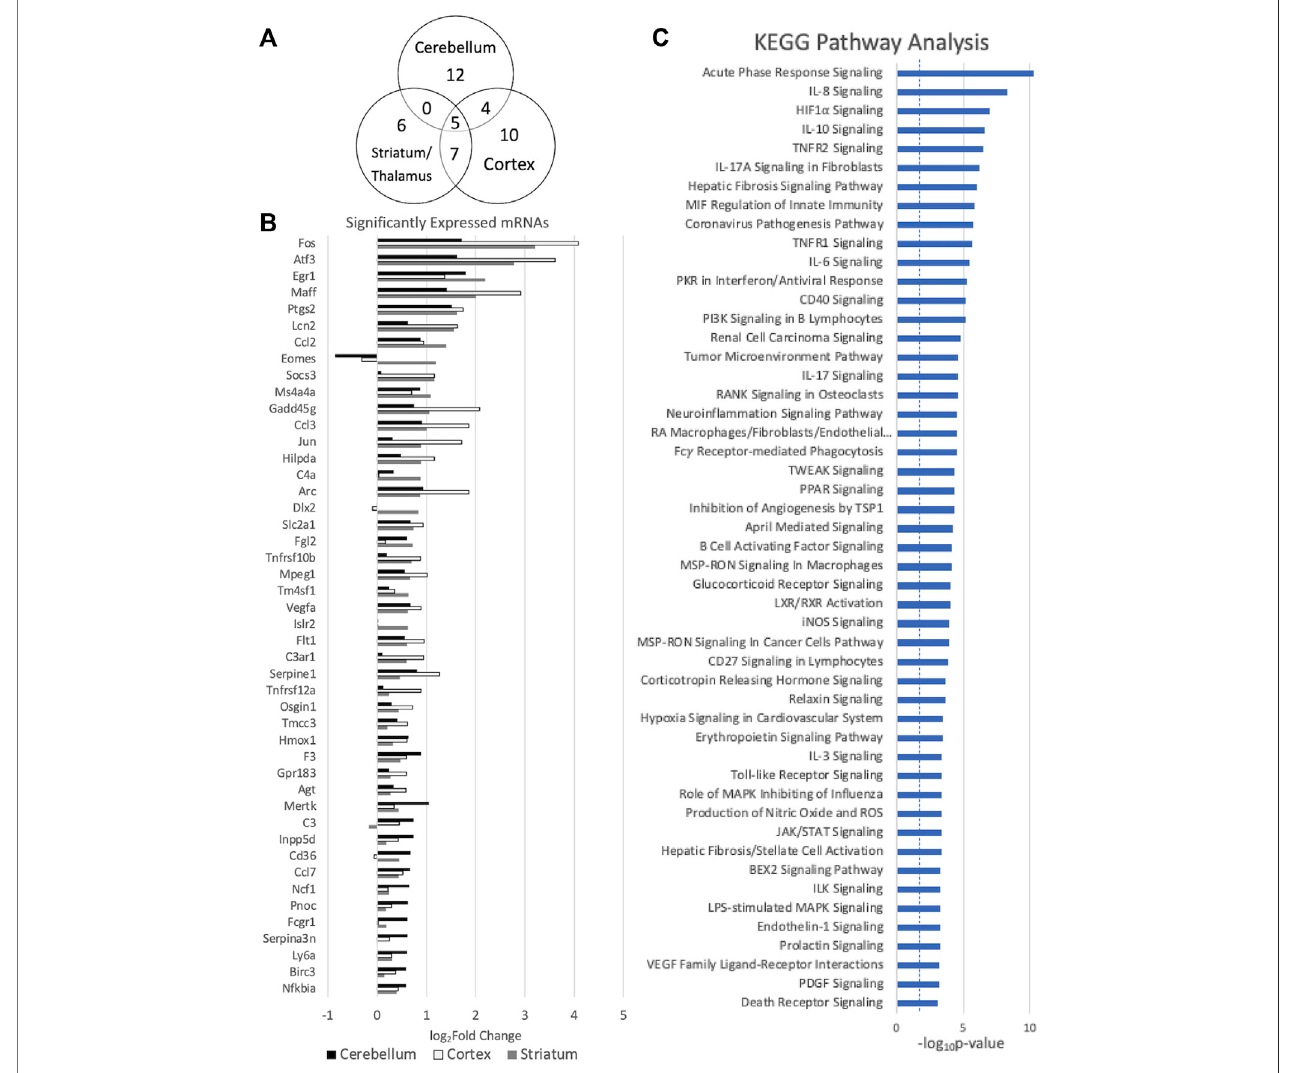
FIGURE3| MessengerRNAs(mRNA) withsigni fi cantdifferential expression inmore than one region. (A) Venn diagram demonstratingthe number ofmRNAs with signi fi cant differential expression and the overlap between each region; (B) differential expression of the mRNAs with signi fi cant differential expression in at least one region (signi fi cance de fi ned by fold-change > 1.5 and p value and/or false discovery rate < .05), n = 4/group for each region; and (C) KEGG analysis demonstrating the canonical pathways affected by all of the mRNAs demonstrating signi fi cant differential expression. Error bars represent standard error of the mean.